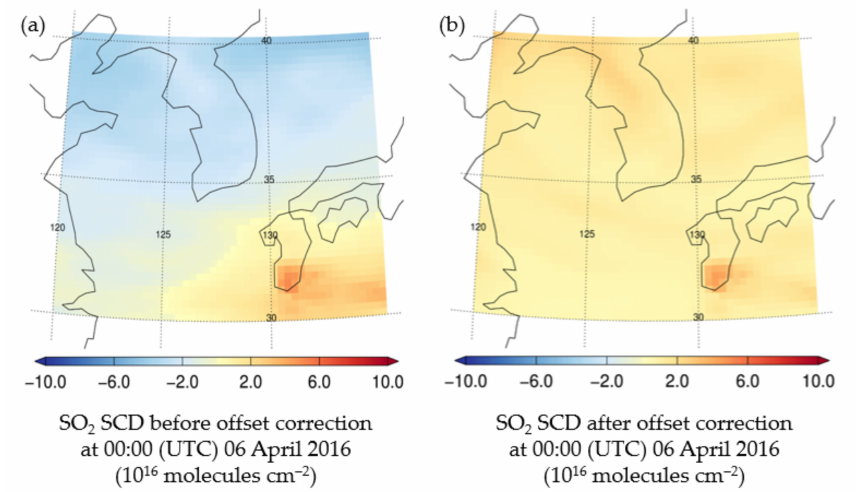
Figure 6. ( a ) SO 2 SCD before offset correction at 00:00 (UTC) 06 April 2016. ( b ) Offset-corrected SO 2 SCD at 00:00 (UTC) 06 April